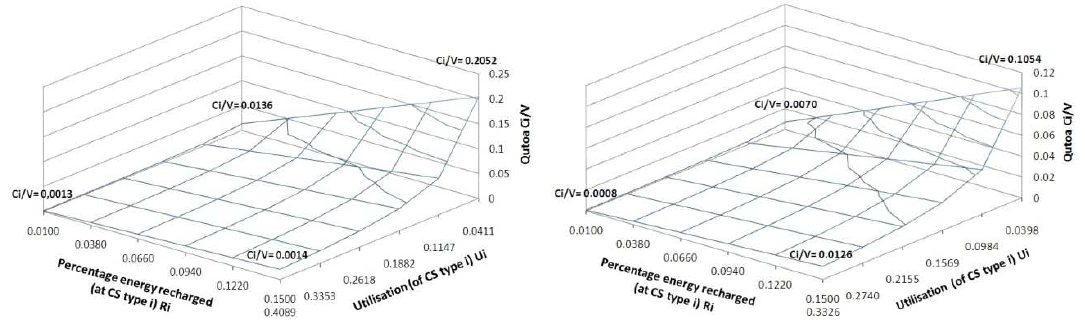
Figure 7. Quotas Ci/V for business fleet vehicles and 22kW (left) and 44 kW (right) charging